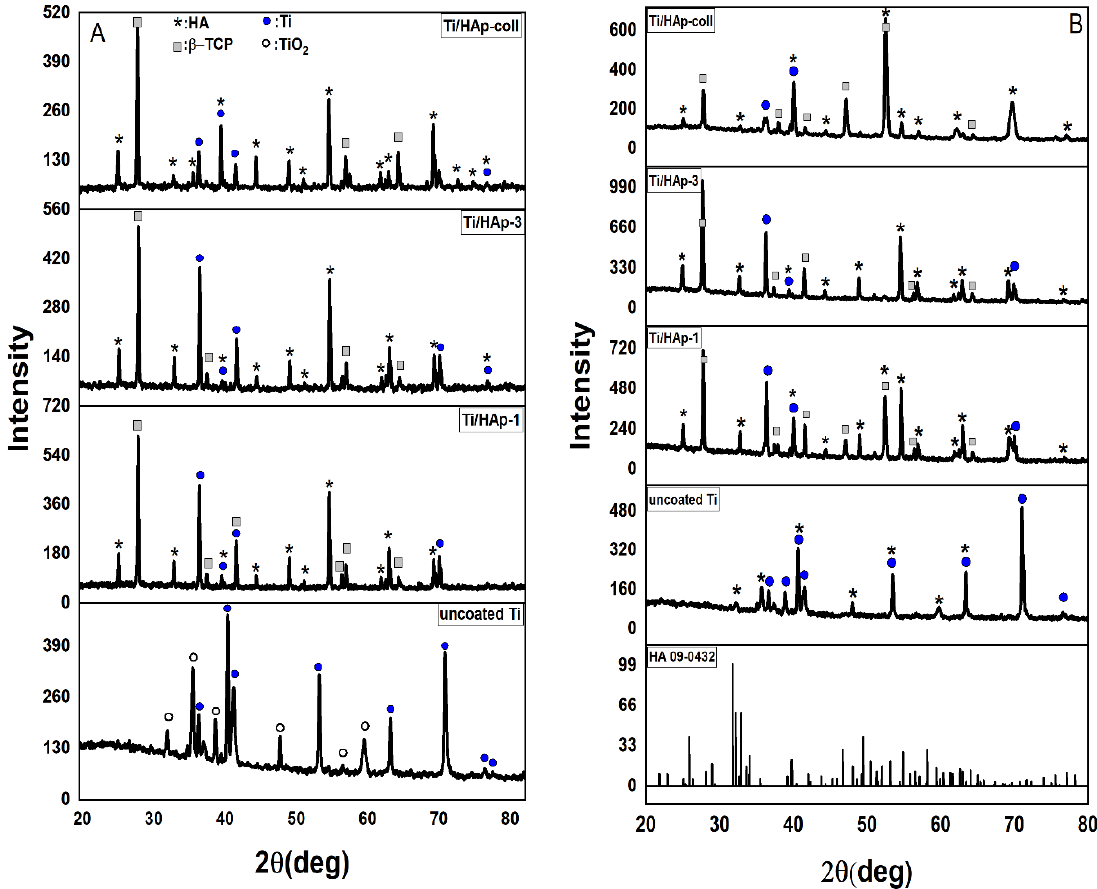
Figure 3. XRD spectra of uncoated-Ti, Ti/HAp-1, Ti/HAp-3, and Ti/HAp-coll coatings before ( A